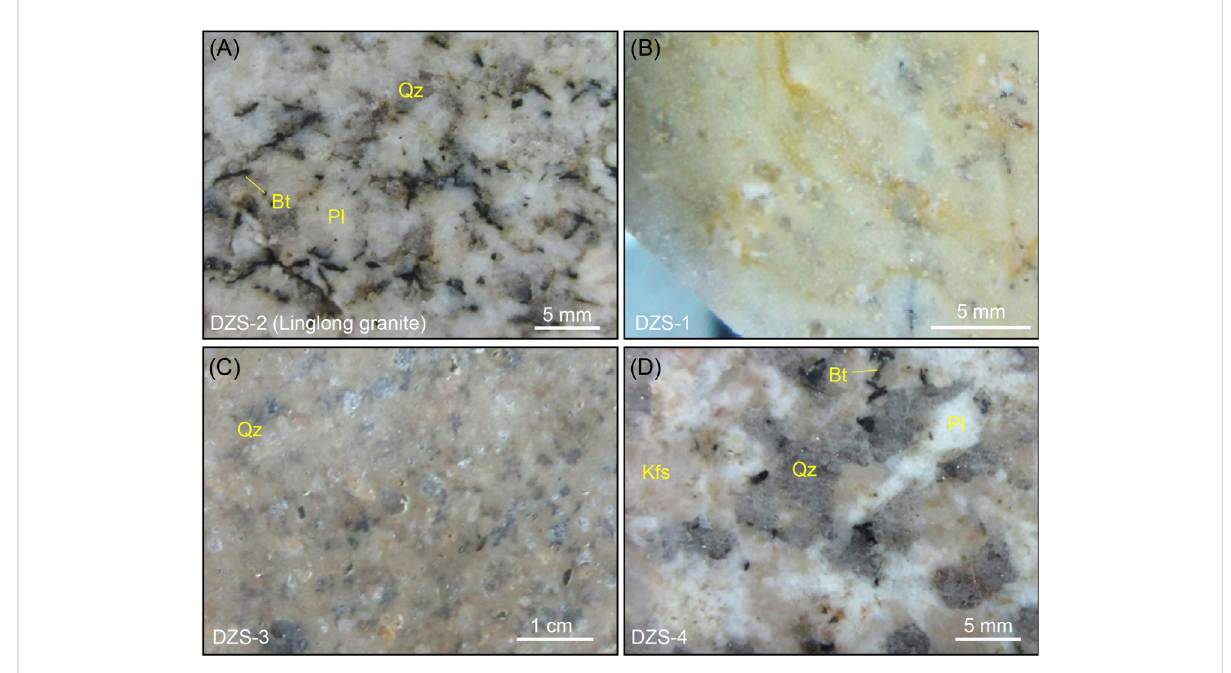
FIGURE 2 (A – D) Photographs of Linglong granite, quartz porphyry, rhyolite porphyry, and Dazeshan biotite granite.